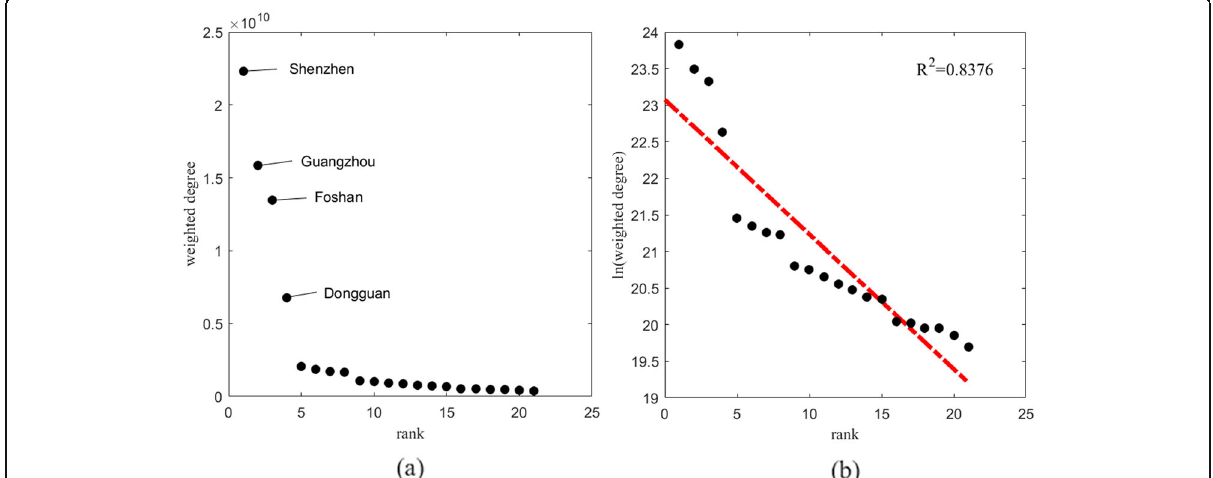
Fig. 4 Correlation between rank and weighted degree : (a) Scatter Plot of rank and weighted degree ; (b) Scatter Plot of rank and ln (weighted